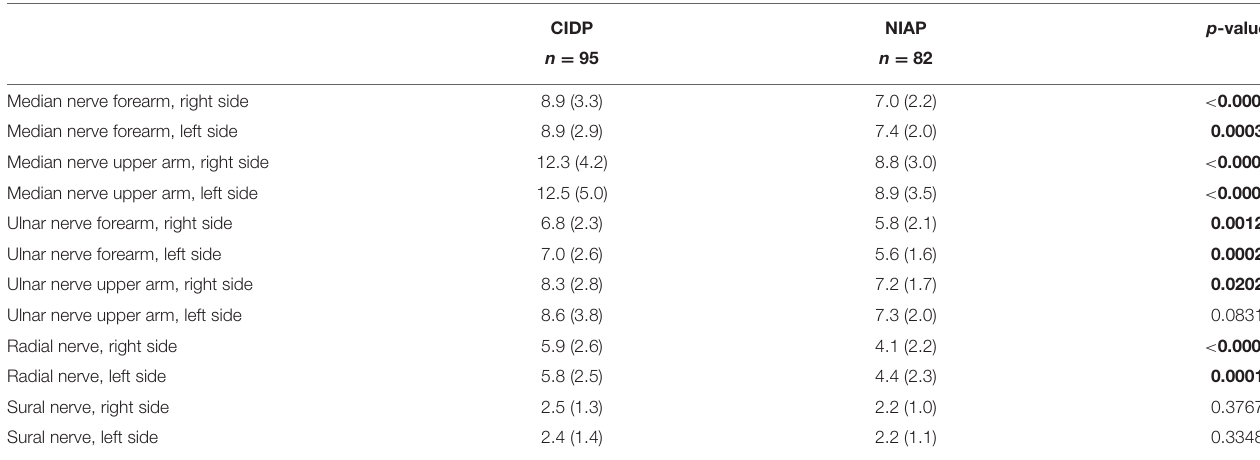
TABLE 3 | Absolute CSA (mm 2 ), mean